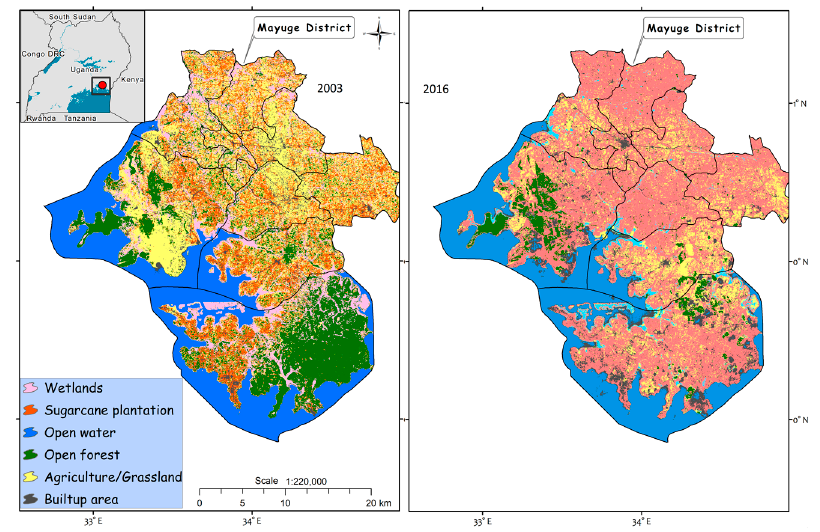
Figure 2. Land use/cover changes in Mayuge District between 2003 and 2016.